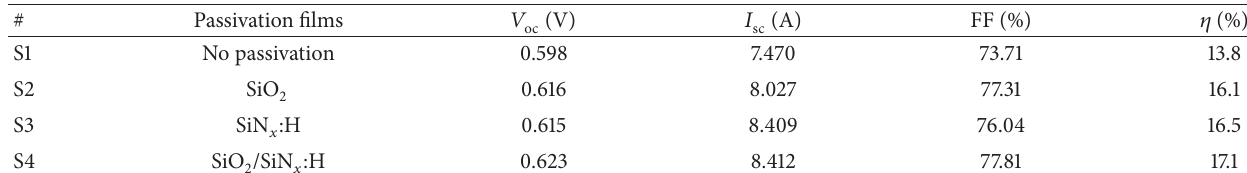
Table 1: The electrical properties of the black silicon solar cells with different passivation films.